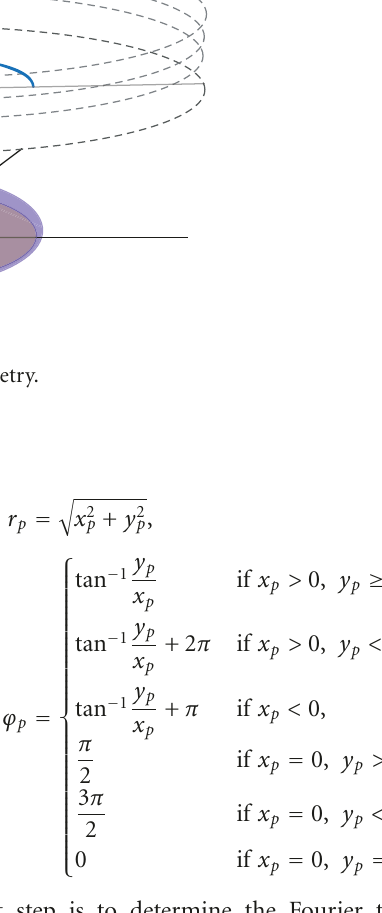
Figure 2: Unprocessed experimental E-CSAR data corresponding to 2 metal ovoids inside a PVC pipe.